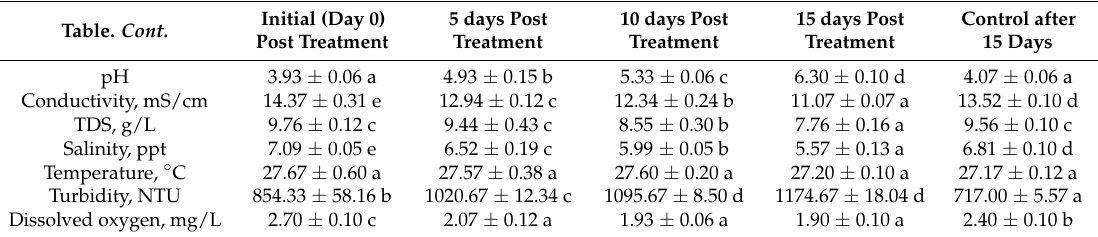
Table 1. In-situ concentration of cassava mill effluents treated with Saccharomyces cerevisiae . Table.